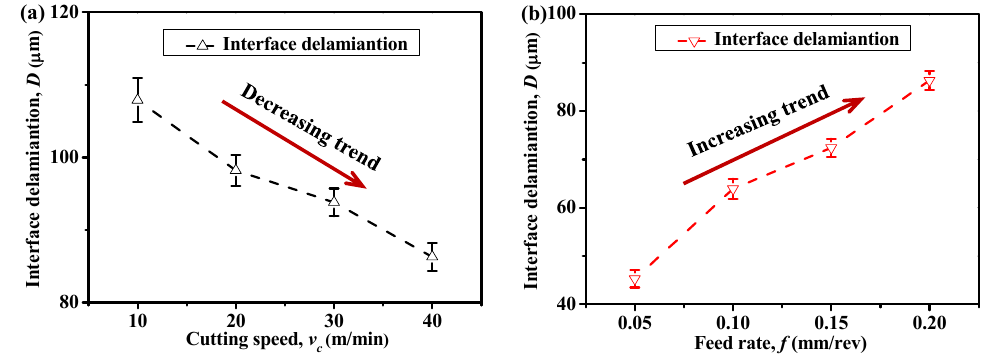
Figure 15. Interface delamination extent ( D ) in function of: ( a ) cutting speed ( v c ) ( f = 0.2 mm/rev and θ = 0°) and ( b ) feed rate ( f ) ( v c = 40 m/min and θ = 0°).